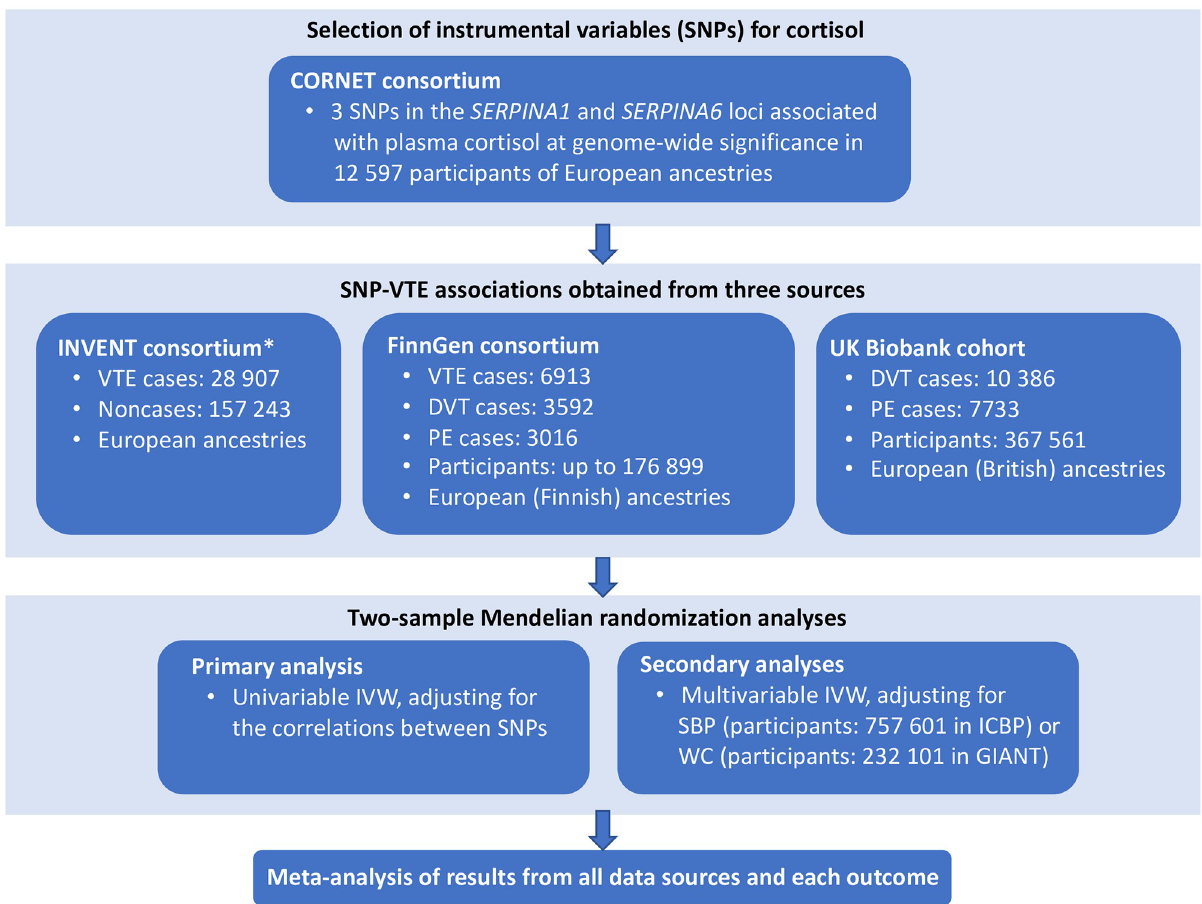
Fig 1. Study overview. Abbreviations: CORNET, CORtisol NETwork; INVENT, International Network Against Venous Thrombosis; DVT, deep vein thrombosis; GIANT, Genetic Investigation of ANthropometric Traits consortium; ICBP, International Consortium of Blood Pressure; IVW, inverse- variance weighted; PE, pulmonary embolism; SBP, systolic blood pressure; SNP, single-nucleotide polymorphisms; VTE, venous thromboembolism; WC, waist circumference. � The INVENT consortium includes participants from the UK Biobank study.